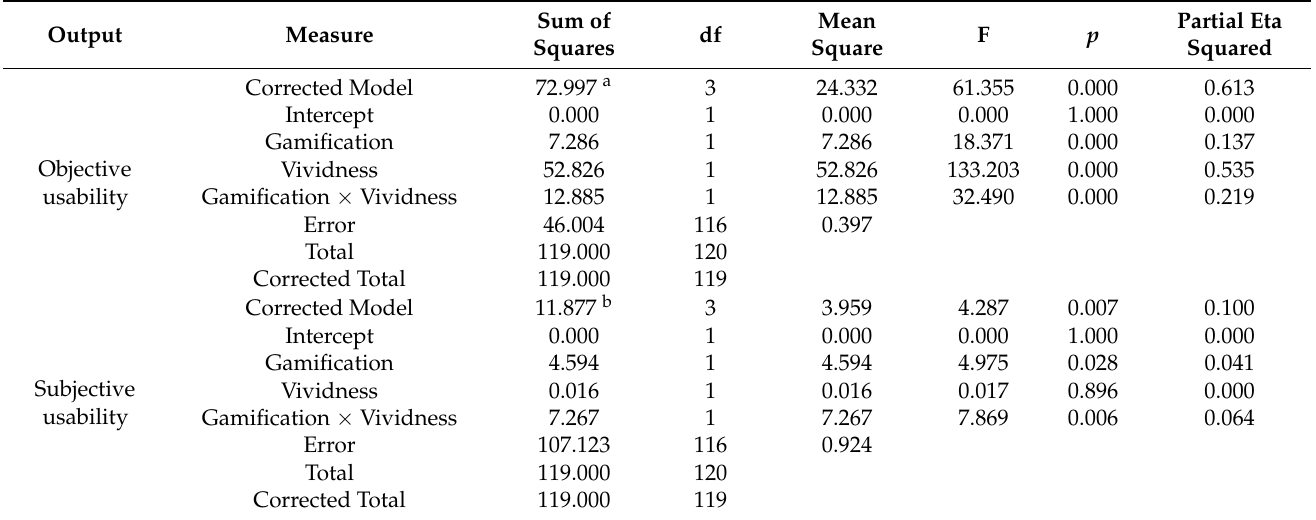
Table 14. Moderated mediation using a two-way analysis of variance (ANOVA) and the moderated mediation relationships between gamification and the vividness of in-person counseling.